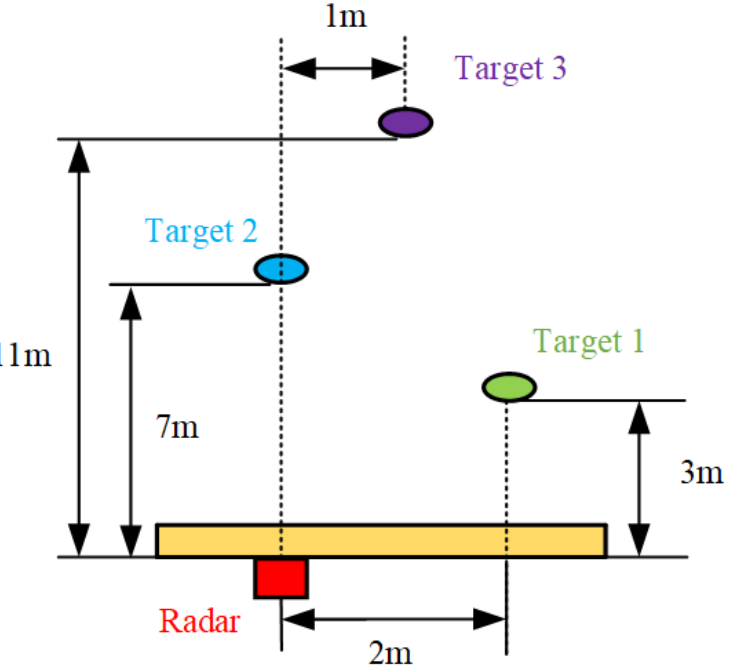
Figure 10. Schematic diagram of the positions of the multi ‐ target experiment.